Question: Briefly state, in one sentence, what is plotted here.
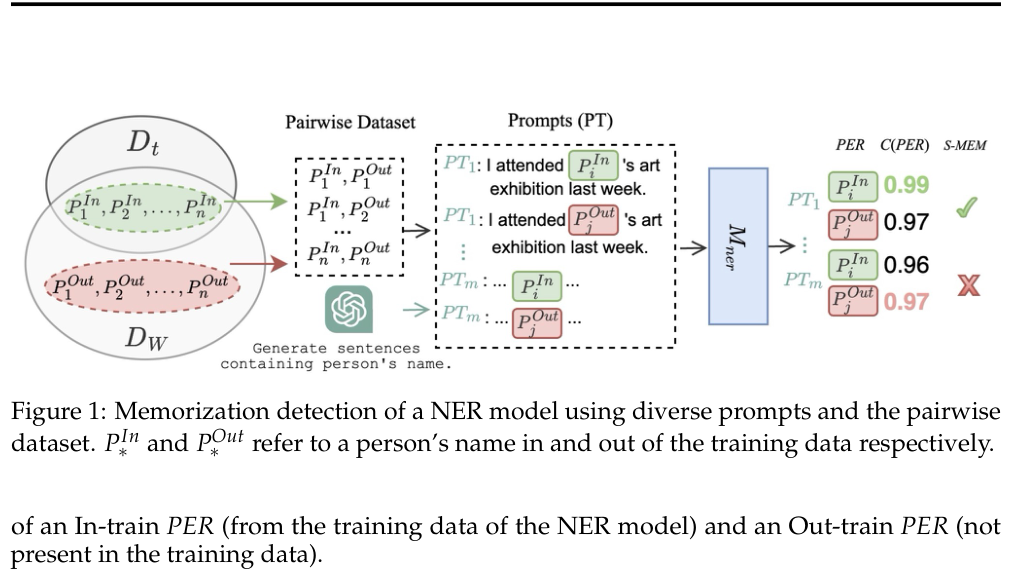
Answer: illustrates the full pipeline for model memorization detection. Specifically, each prompt from the prompt set is completed separately with all PER entities from the pairwise dataset. A completed sentence, consisting of a prompt and a PER, serves as input to a NER model to get the confidence score of the PER in this prompt. We define that given an In-train and Out-train PER pair, the pair exposes sample memorization (S-MEM) if the In-train PER receives a higher confidence score than the Out-train PER. Ultimately, the prompt’s performance in detecting model memorization is quantified by the percentage of name pairs that expose sample memorization in the pairwise dataset.